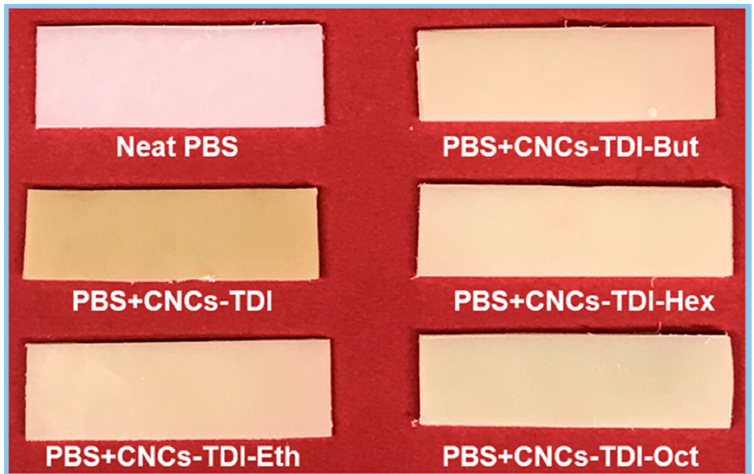
Figure 6. The change in the color of poly(butylene succinate) (PBS) upon processing with the modified CNCs. Polymers 2019 , 11 , x FOR PEER REVIEW 10 of 14